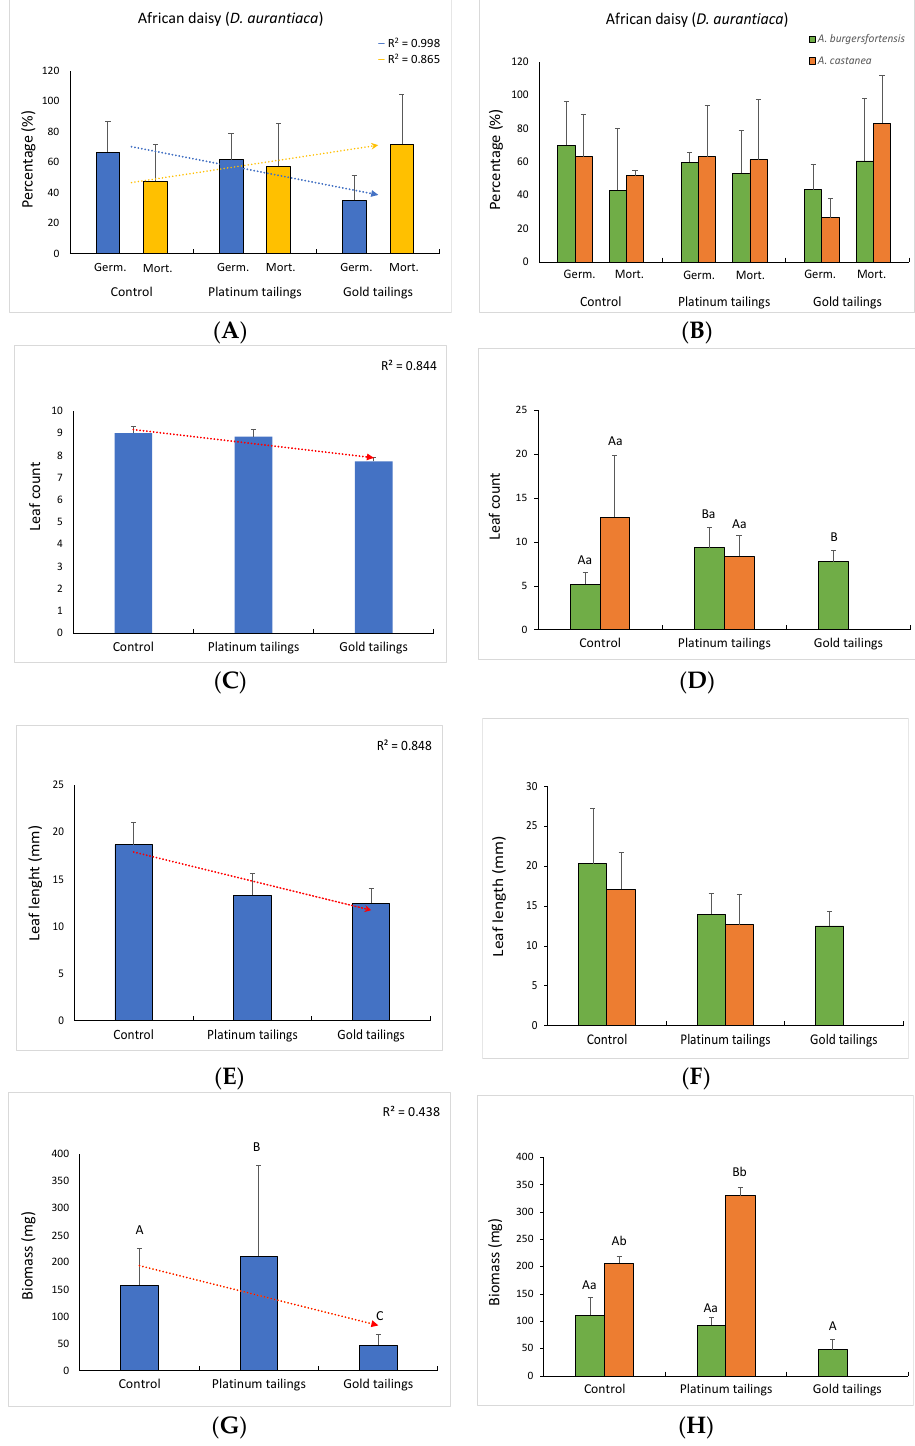
Figure 4. Mean values (± sd) and regression curves for developmental parameters of African daisy considering only the soil treatments ( A , C , E , G ) and the soil treatments in the presence of aloes ( B , D , F , H ). Different upper-case letters: significant differences ( p < 5%) among individuals in different soil treatments in the presence of the same aloe species. Different lower-case letters: significant differences among individuals grown with different aloe species, in the same soil treatment. Bermuda grass ( C. dactylon )